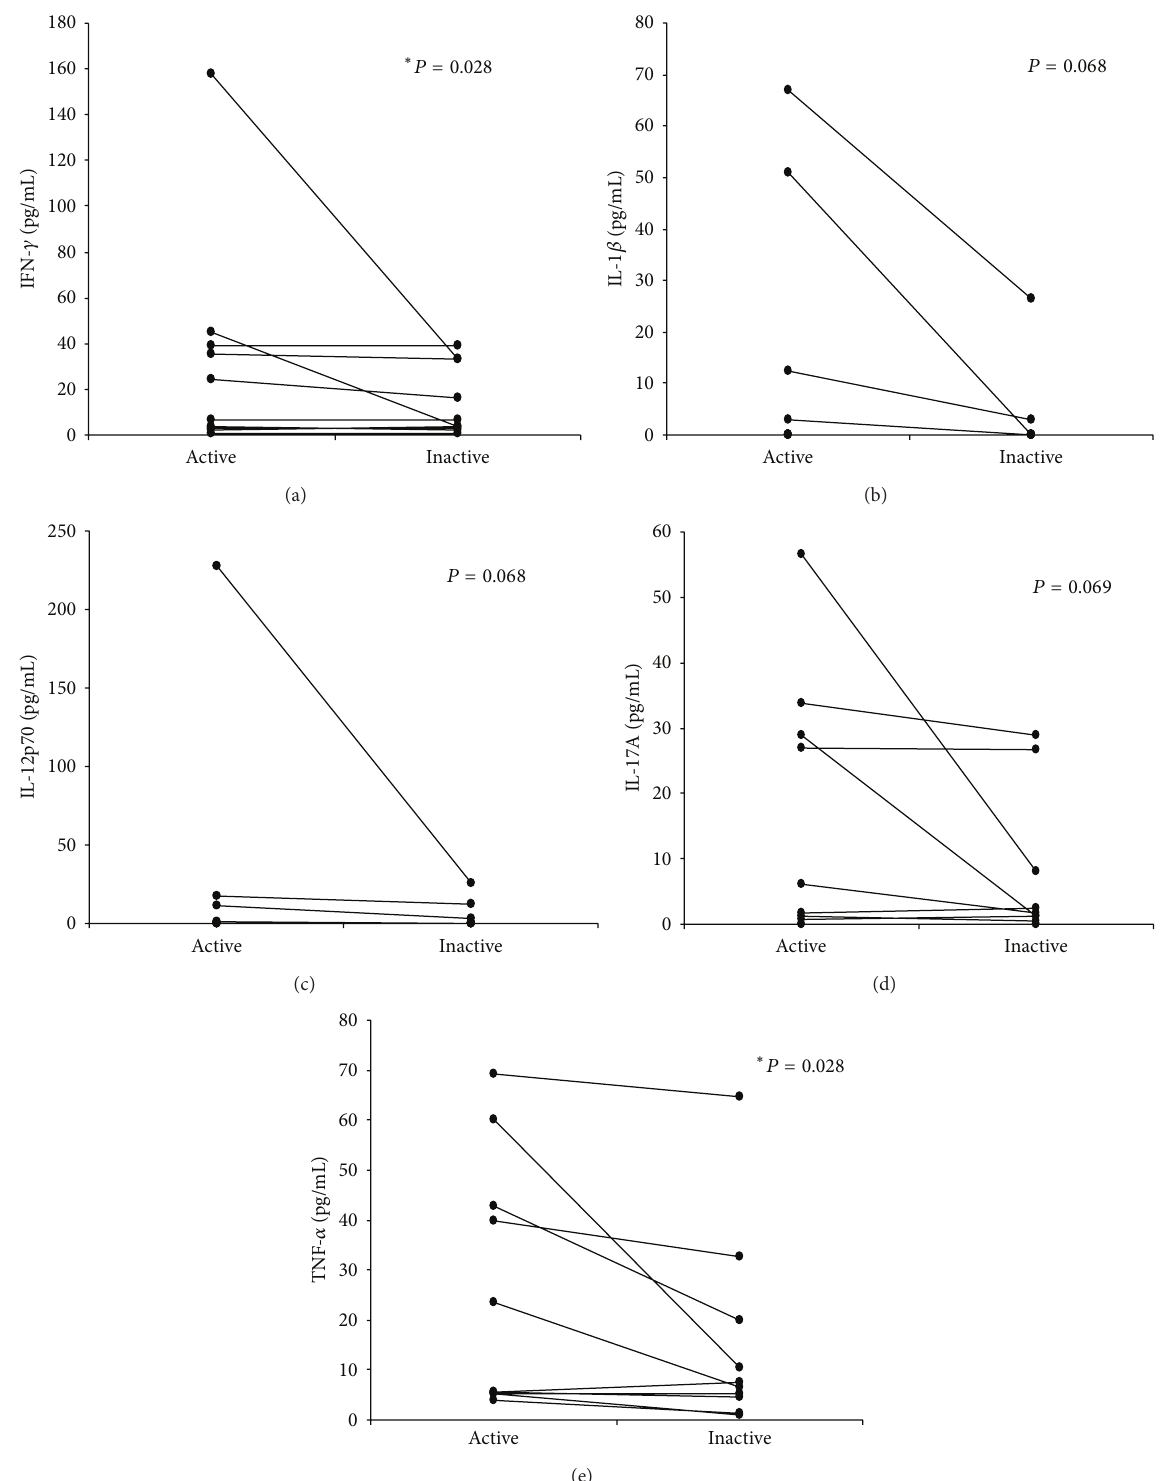
Figure 2: Levels of IFN- 𝛾 , IL-12p70, IL-17A, IL-1 𝛽 , and TNF- 𝛼 (pg/mL) ± SEM in the serum of patients with uveitis associated with BD during the active and inactive stages ( 𝑁 = 10 ). Statistical analysis was conducted using the Wilcoxon test ( ∗ 𝑃 < 0.05